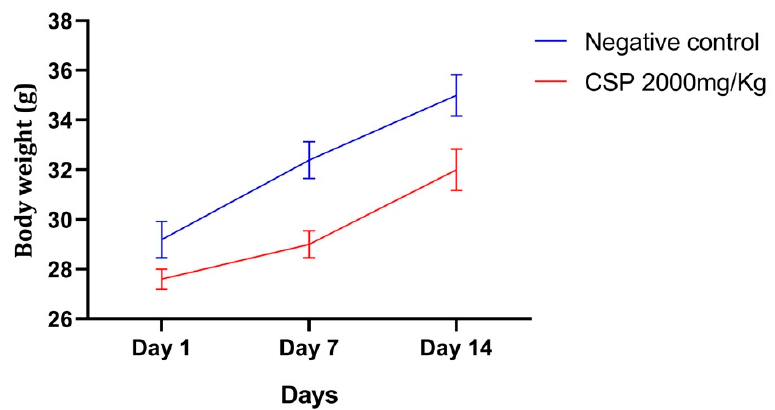
Figure 4. CSP effect on body weight changes in mice. Data presented as mean ± SD ( n = 6). Table 2. Assessment of a relative weight of organs in the acute toxicity study.